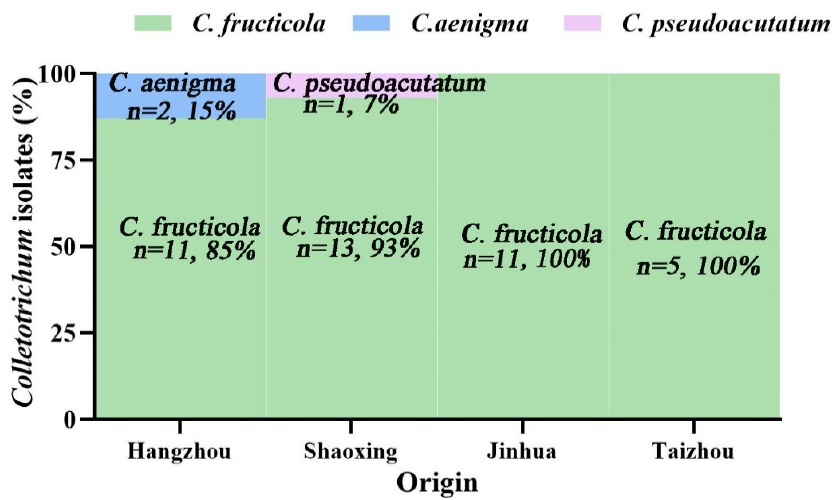
Figure 3. Distribution of Colletotrichum species in four grape-planting regions in Zhejiang, China. n = number of Colletotrichum isolates analyzed. 13 Colletotrichum isolates from Hangzhou contained C. fructicola (11 isolates, 85%) and C. aenigma (two isolates, 15%); 14 isolates from Shaoxing contained C. fructicola (13 isolates, 93%) and C. pseudoacutatum (one isolate, 7%); a further 11 isolates from Jinhua and 5 isolates from Taizhou all were C. fructicola.